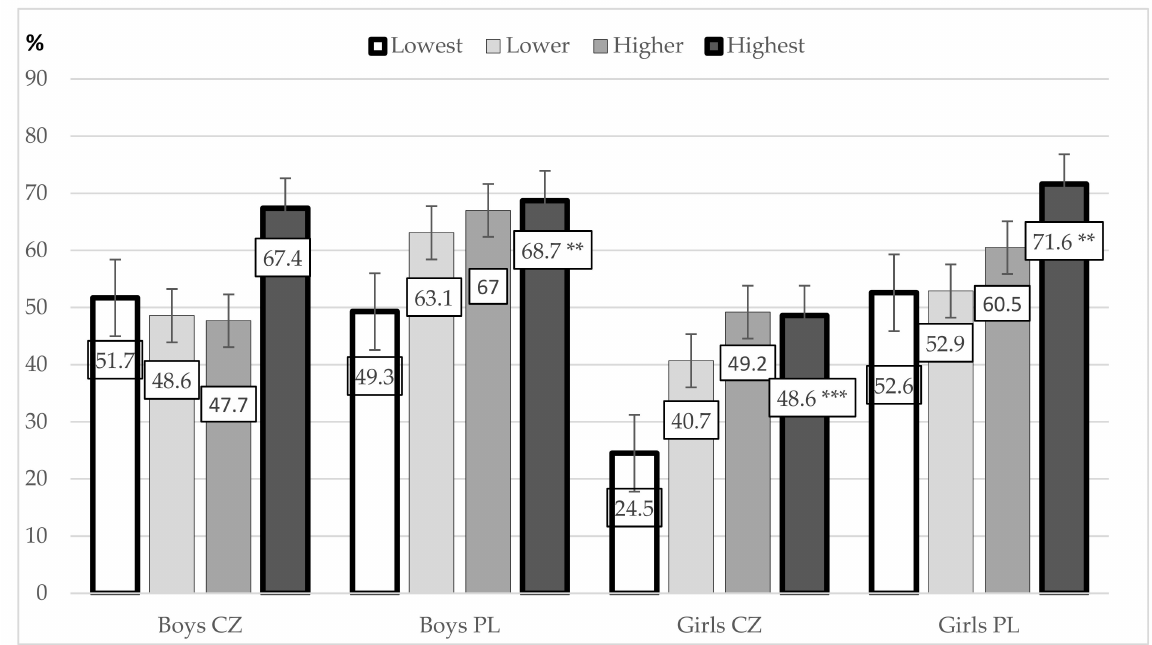
Figure 4. Associations between life satisfaction quartiles (lowest, lower, higher, highest) and active participation in organized PA (percentage of those participating) among Czech and Polish boys and girls. Significant difference between the groups with the lowest and highest life satisfaction (LS): ** p < 0.01; *** p < 0.001. Boys with the highest LS had 1.94 times higher chances of meeting the recommenda- tion of at least three periods of no less than 20 min of VPA per week than boys with